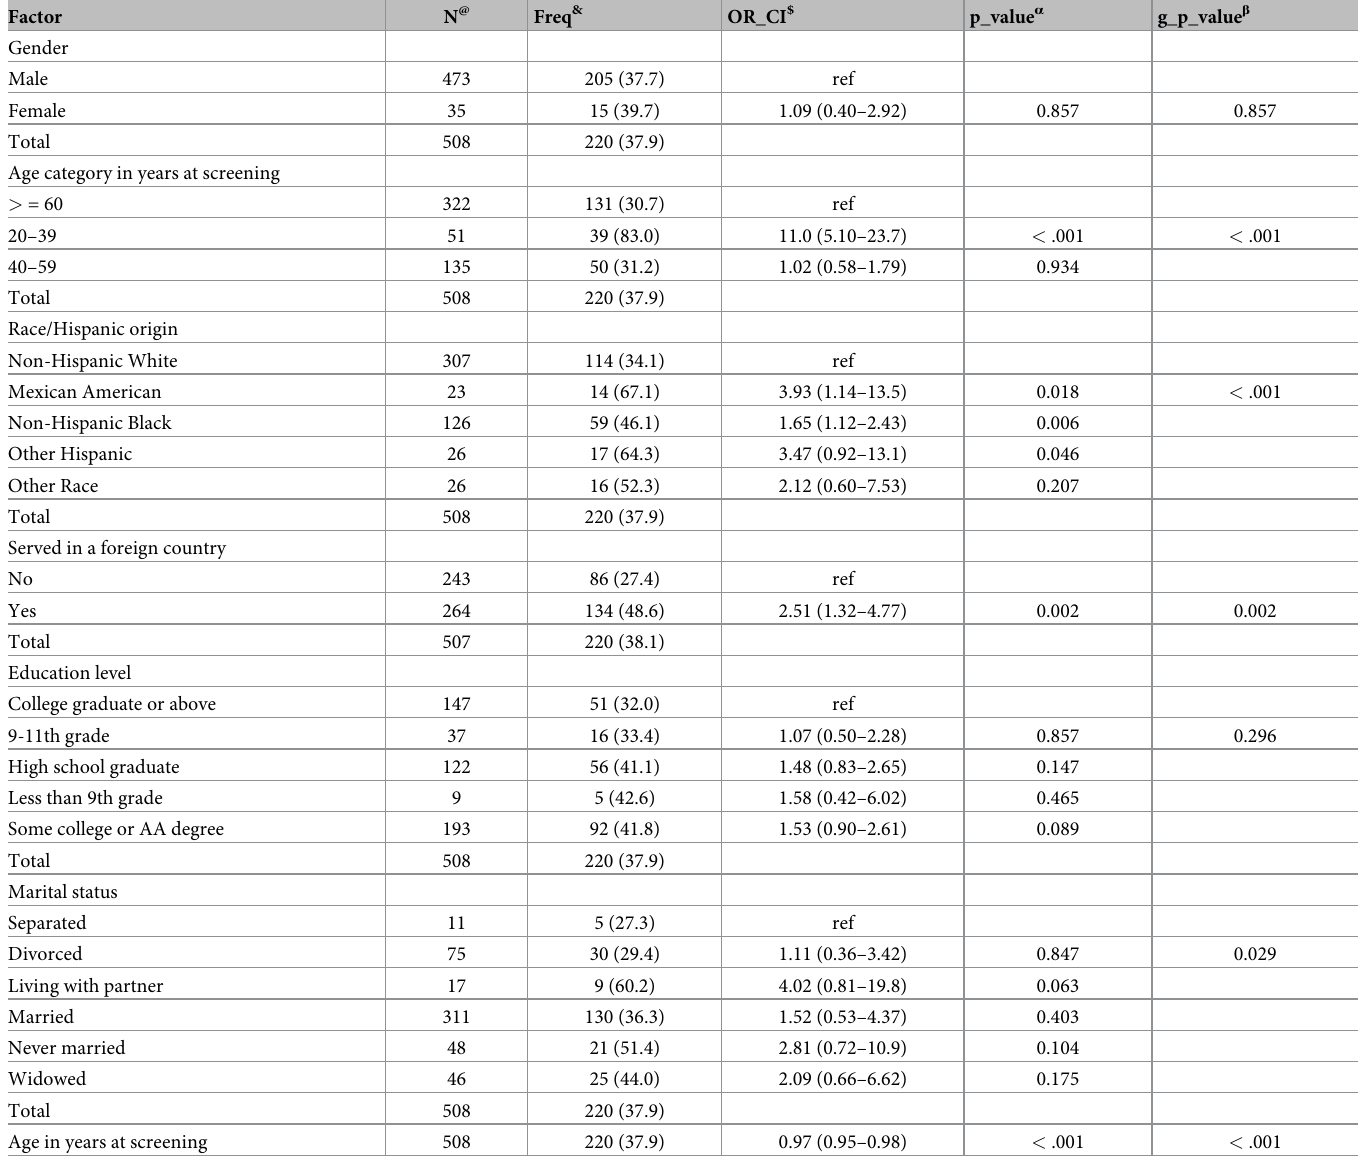
Table 2. Output of simple logistic regression model results from %svy_unilogit